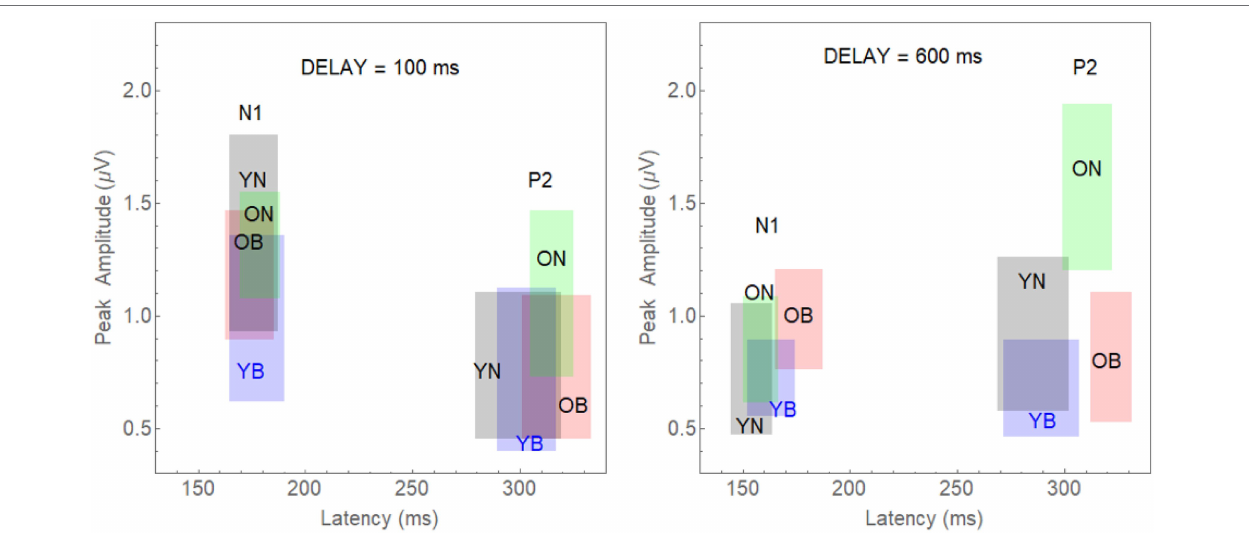
FIGURE 4 | The 95% joint CI rectangles for latency and amplitude of the N1 and P2 waves in Younger and Older Adults for the Noise and Babble Maskers and 100 and 600 ms Delays. Left-panel : 95% CI rectangles for a target word onset delay of 100 ms. Separate rectangles are shown for the two Age Groups reporting heard words in both Noise and Babble for the two different waves (N1 and P2). The grey rectangles depict the CIs for young adults in noise (YN); the blue rectangles are for young adults in babble (YB). The green rectangles are for old adults in noise (ON), and the red rectangles are for old adults in babble (OB). Right-panel : The equivalent rectangles for a target word onset delay of 600